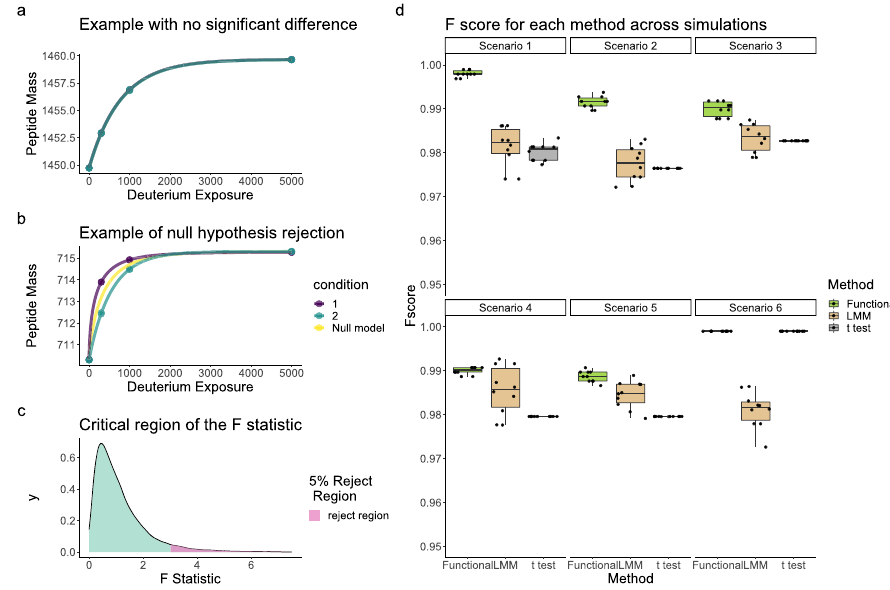
Fig. 1 Functional model and performance in simulations. a – c Cartoon of the proposed approach to statistical analysis of HDX-MS data. a) Functional models fi t where there is no difference between the conditions. b Functional models fi tted to HDX data where there are signi fi cant differences. c The F distribution with 5% critical region identi fi ed in magenta. d Simulation study for HDX data showing improved performance of our proposed functional method (functional) for linear mixed models (LMM) and the t test ( t test). These simulations encompass scenarios with differing numbers of time points and replicates. We refer the reader to the methods for